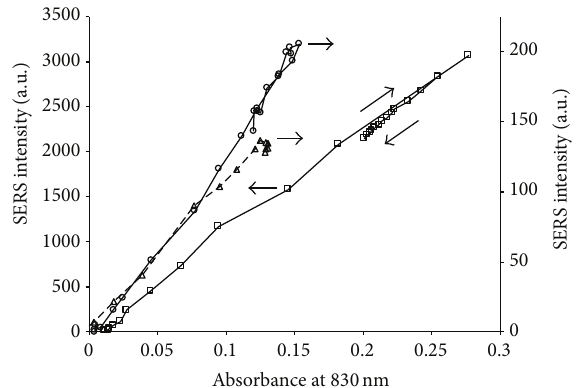
Figure8:InthisfigurecorrectedSERSintensitiesareplottedagainst the corresponding aggregate extinction data (measured at 830 nm) for R6G (circles), MPY (squares), and MBA titrated with KCl (triangles). R6G and MBA are associated with the right 𝑦 -axis and MPY is associated with the left.